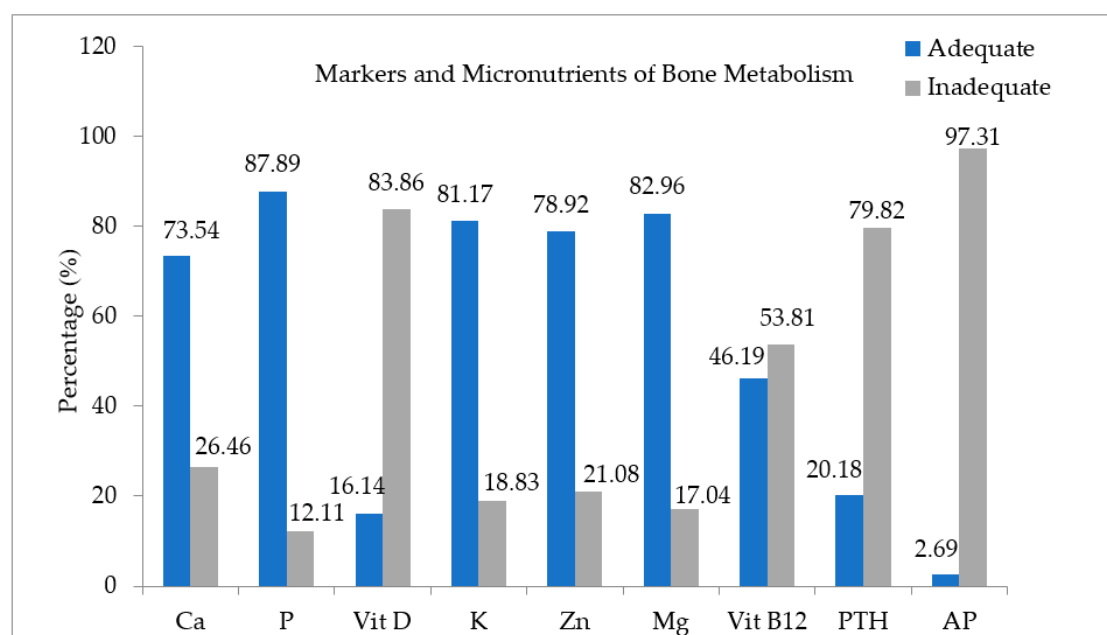
Figure 2. (%) of adequacy and inadequacy of markers and micronutrients of bone metabolism of